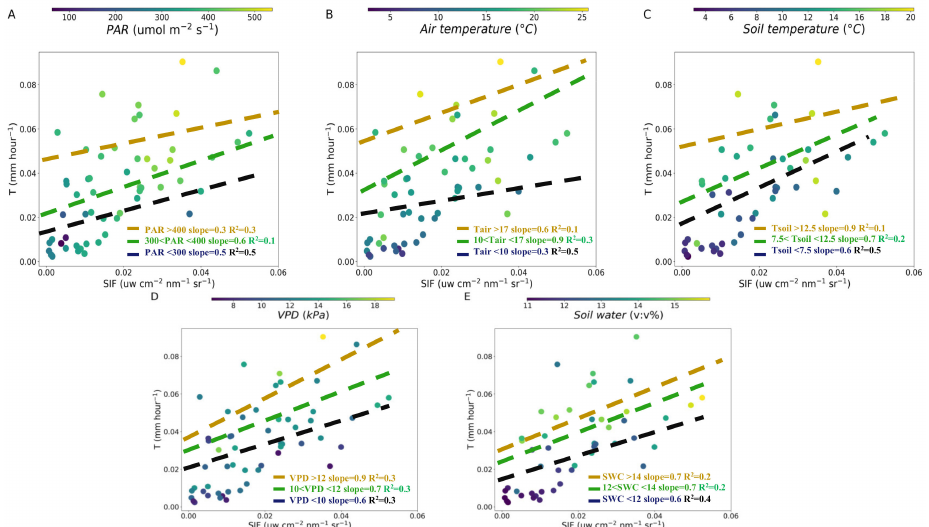
Figure 5. Relationship between SIF and T over PAR ( A ), air temperature ( B ), soil temperature ( C ), VPD ( D ) and soil water content ( E ) at daily scale. The dashed lines are linear regression fitted to the SIF and T under different variables value interval: the lowest (black, <33%), medium (green, 33%–66%) and highest (yellow, >66%) at daily scale,